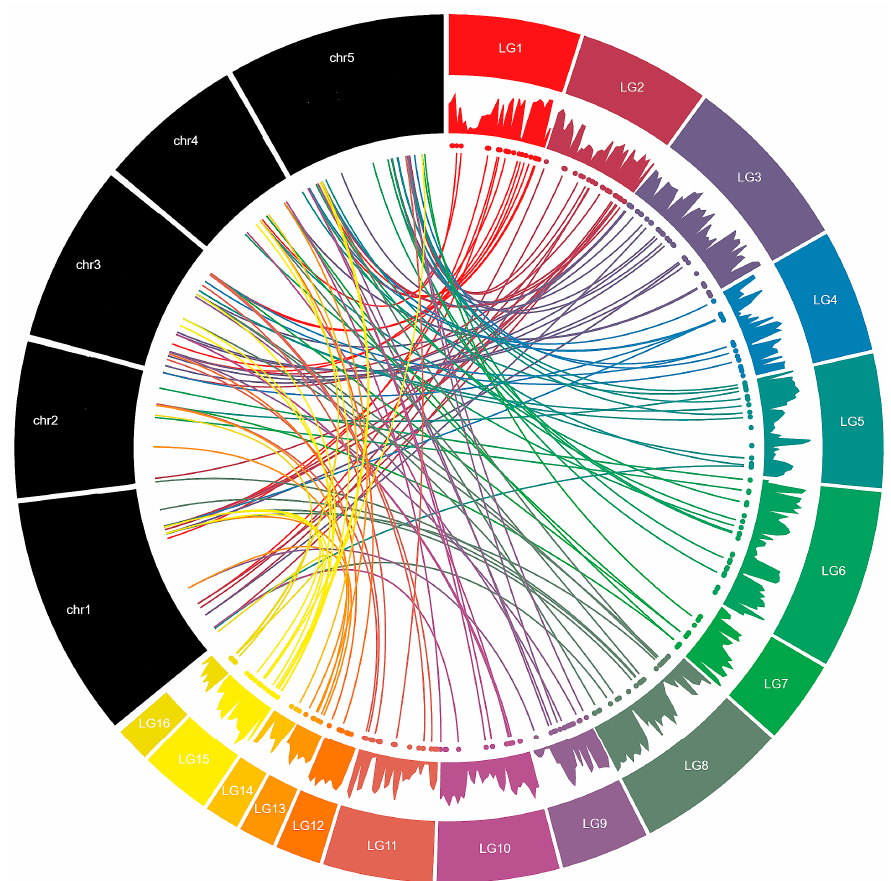
Figure 3. Syntenic relationships between MYB genes in sesame and Arabidopsis genomes. The black bars represent the chromosomes of Arabidopsis whereas the colored bars represent the linkage groups of the sesame genome. The numbers LG01–16 represent linkage groups within the sesame genome and the five Arabidopsis chromosomes are labeled Chr1–Chr5. The area chart displays the gene density along the LGs in the sesame genome. The colored dots represent the locations of the SIMYB genes along the LGs. Colored lines indicate orthologous genes in sesame and Arabidopsis .